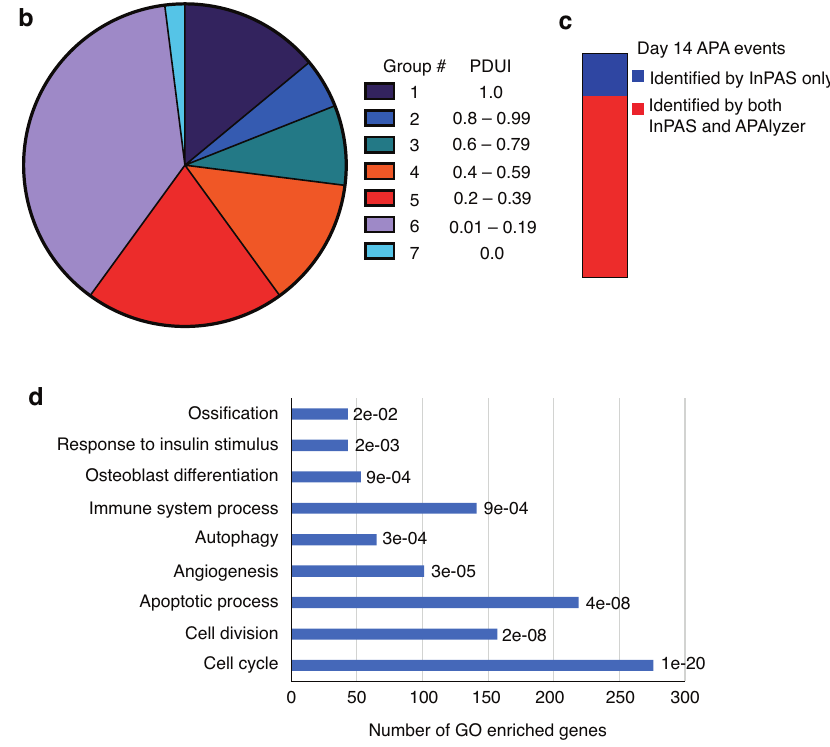
Fig. 2 APA is commonly found in transcripts that are expressed in the callus on day 14 postfracture. a Schematic of the short APA (sAPA) and long APA (lAPA) isoforms of the same gene. Utilization of the proximal polyadenylation site (pPA) con fi nes the size of the 3 ′ UTR to the constitutive UTR (cUTR), generating the sAPA isoform. On the other hand, utilization of the distal PA (dPA) results in the inclusion of the alternative UTR (aUTR) of the 3 ′ UTR, generating the lAPA isoform. The InPAS-based calculation of PDUI values is provided. b Pie chart presentation of the distribution of the indicated 7 PDUI groups in the transcriptome of the d14 callus. c Presentation of the overlap between the APA events in the transcriptome of the d14 callus that were identi fi ed by InPAS and APAlyzer. Events identi fi ed by both programs are shown in red; events identi fi ed by InPAS alone are shown in blue. d GO analysis of APA events in d14 calli. Signi fi cantly enriched functional categories are shown, and the false discovery rate (FDR) of enrichment for each pathway is given (comprehensive lists of signi fi cantly enriched functional categories are provided in Fig. S7 and Table